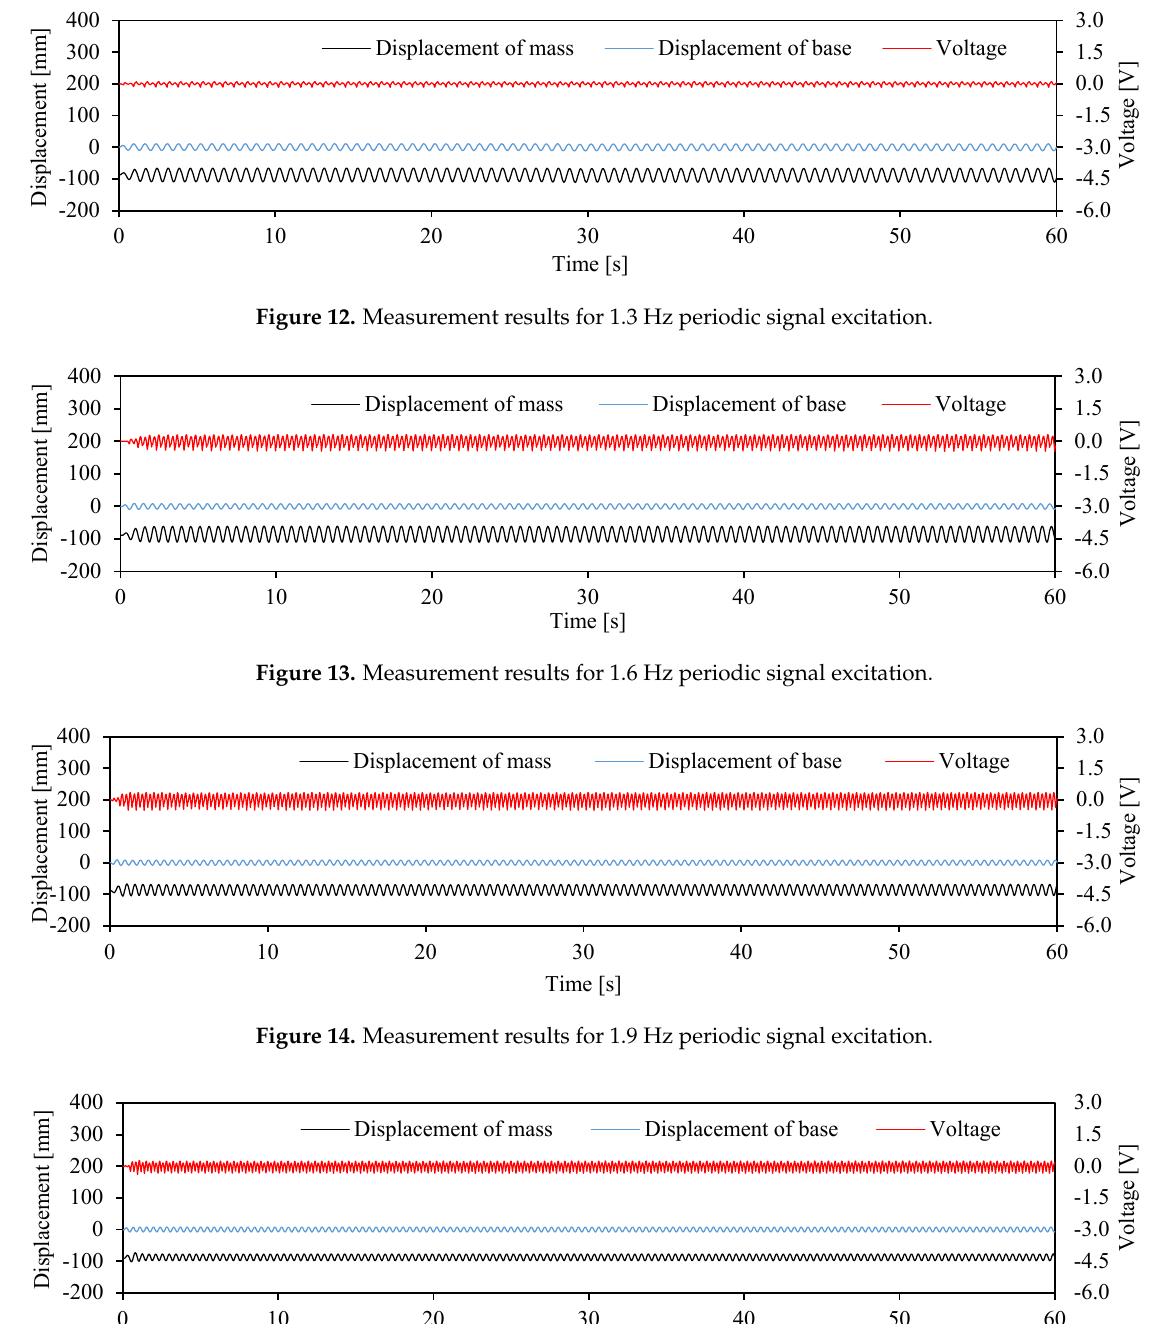
were 14.94 and 7.39 mm, respectively, which resulted in 0.12 mW of power generated.